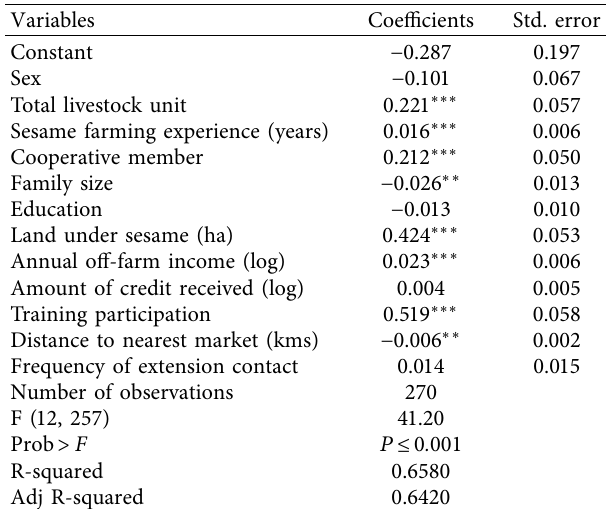
Table 4: OLS estimation of determinants of quantity supply of sesame